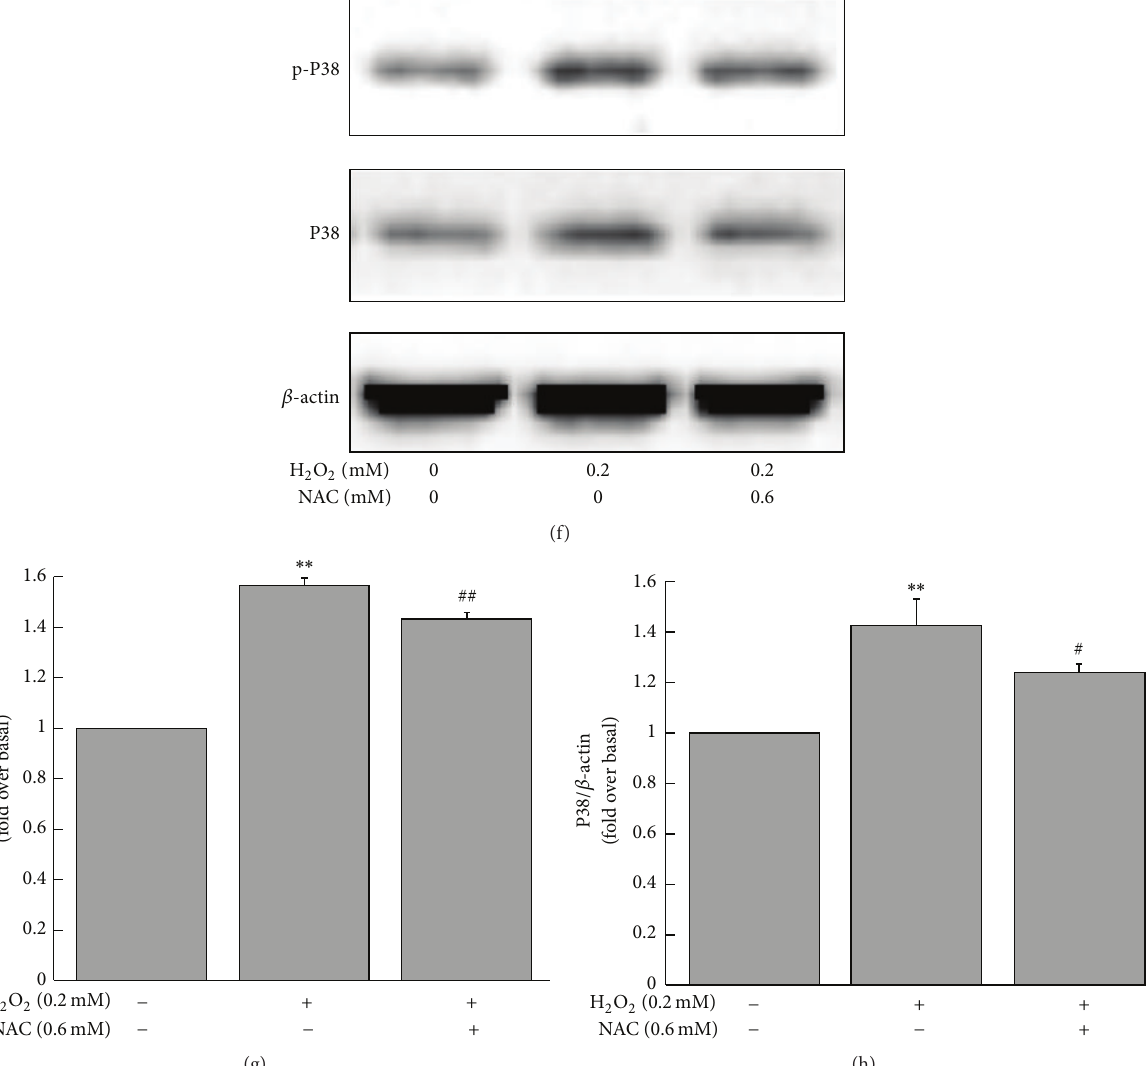
Figure 8: Effects of H 2 O 2 on ROS production (a), apoptotic rate (b), and expression of MAPK in MIN6 cells. Results shown in (a), (b), (d), (e), (g), and (h) are fold change compared to baseline (0mM H 2 O 2 + 0 mM NAC). ∗∗ 𝑝 < 0.01 , ∗∗∗ 𝑝 < 0.001 compared to control group (0mM H 2 O 2 + 0 mM NAC). # 𝑝 < 0.05 , ## 𝑝 < 0.01 compared to H 2 O 2 group (0.2 mM H 2 O 2 + 0 mM